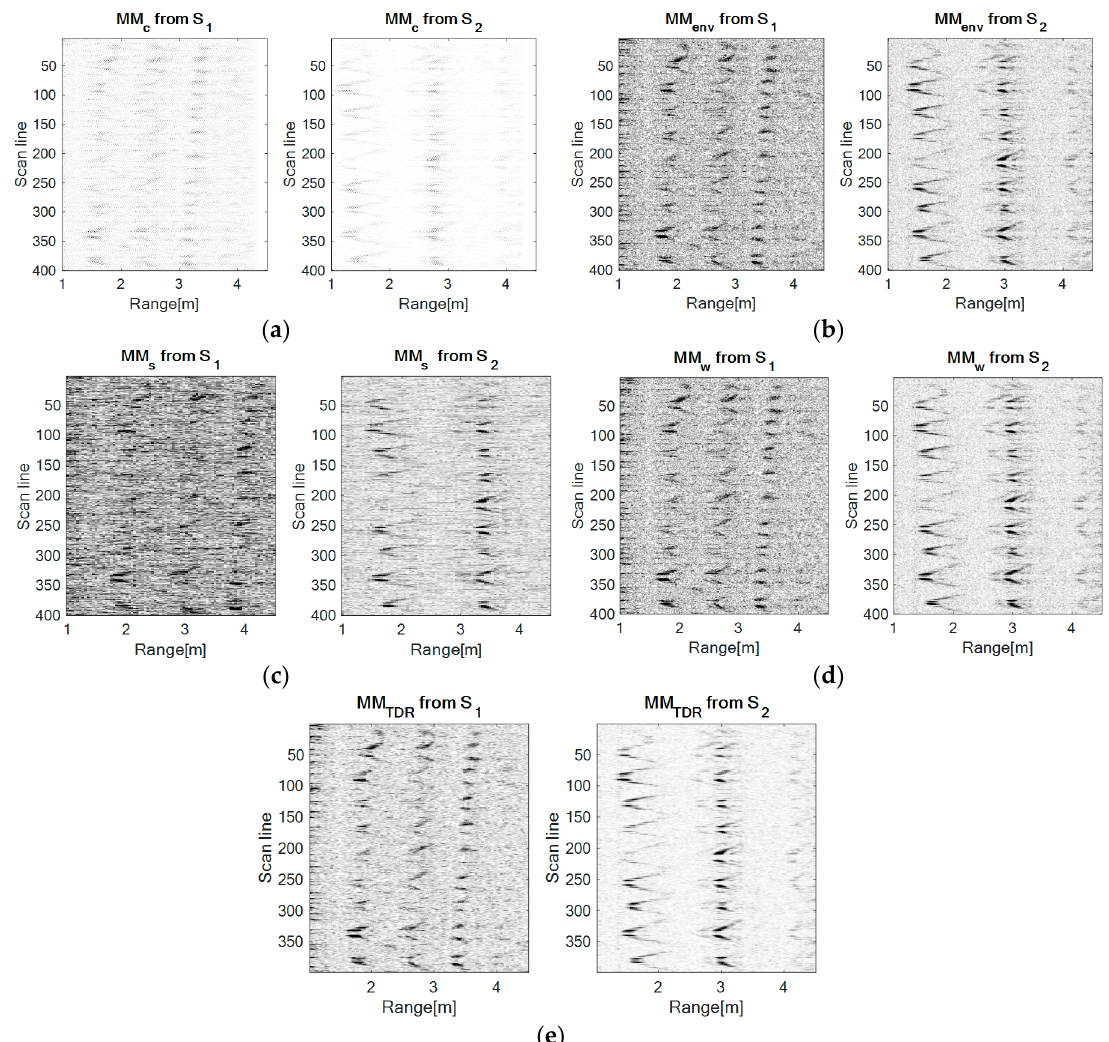
Figure 8. The movement maps for the up-down configuration obtained with each method: ( a ) The correlation method, ( b ) the envelope detection method, ( c ) the spectrogram method: Window size: 64, number of overlapped samples: 60, number of FFT points: 128, ( d ) the wavelet transform method: Mother Morlet wavelet, ( e ) the TDR RPA method: m = 5, d = 1.